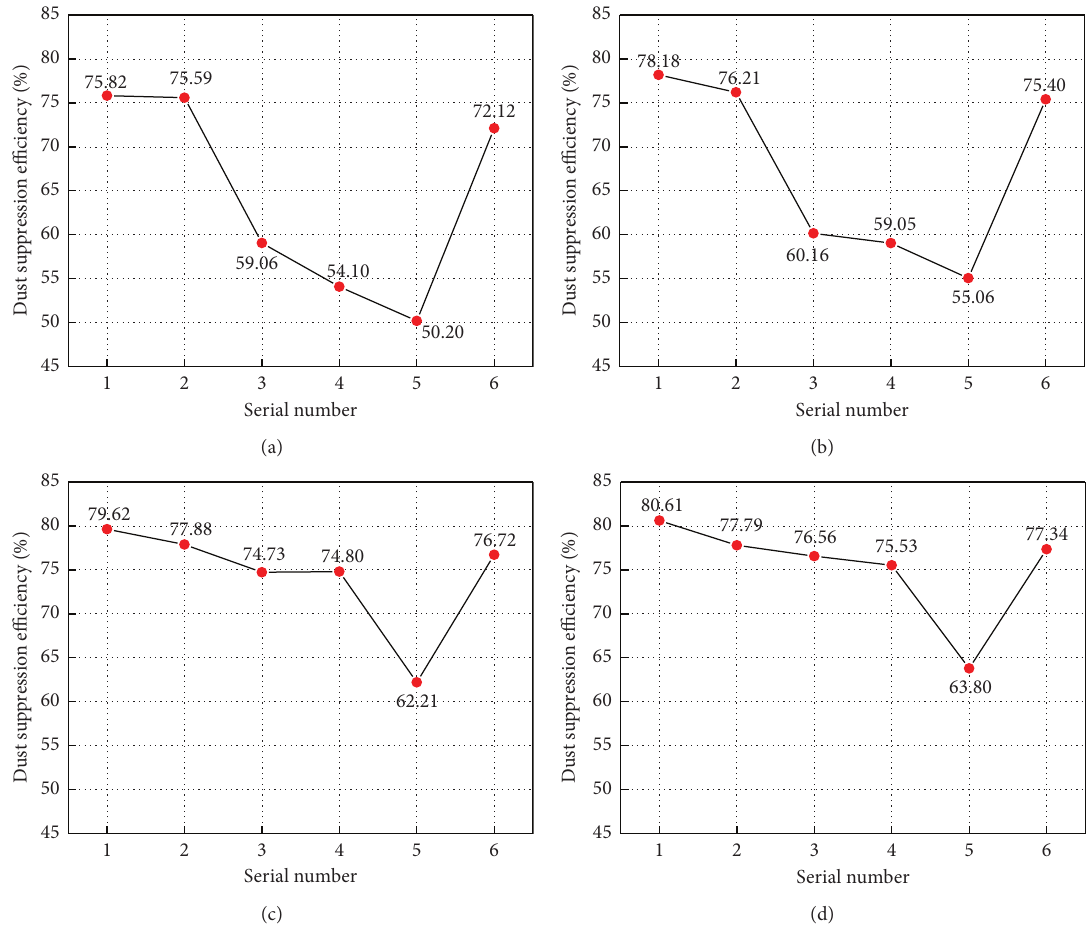
Figure 13: The dust-suppression efficiencies via spraying under different water-supply pressures: (a) p � 0 . 5MPa; (b) p � 1 . 0MPa; (c) p � 1 . 5MPa; (d) p � 2 . 0MPa. Table 3: Growth rates of dust-suppression efficiency within different pressure range. Growth rate of dust suppression efficiency (%) Pressure range (MPa) Fat